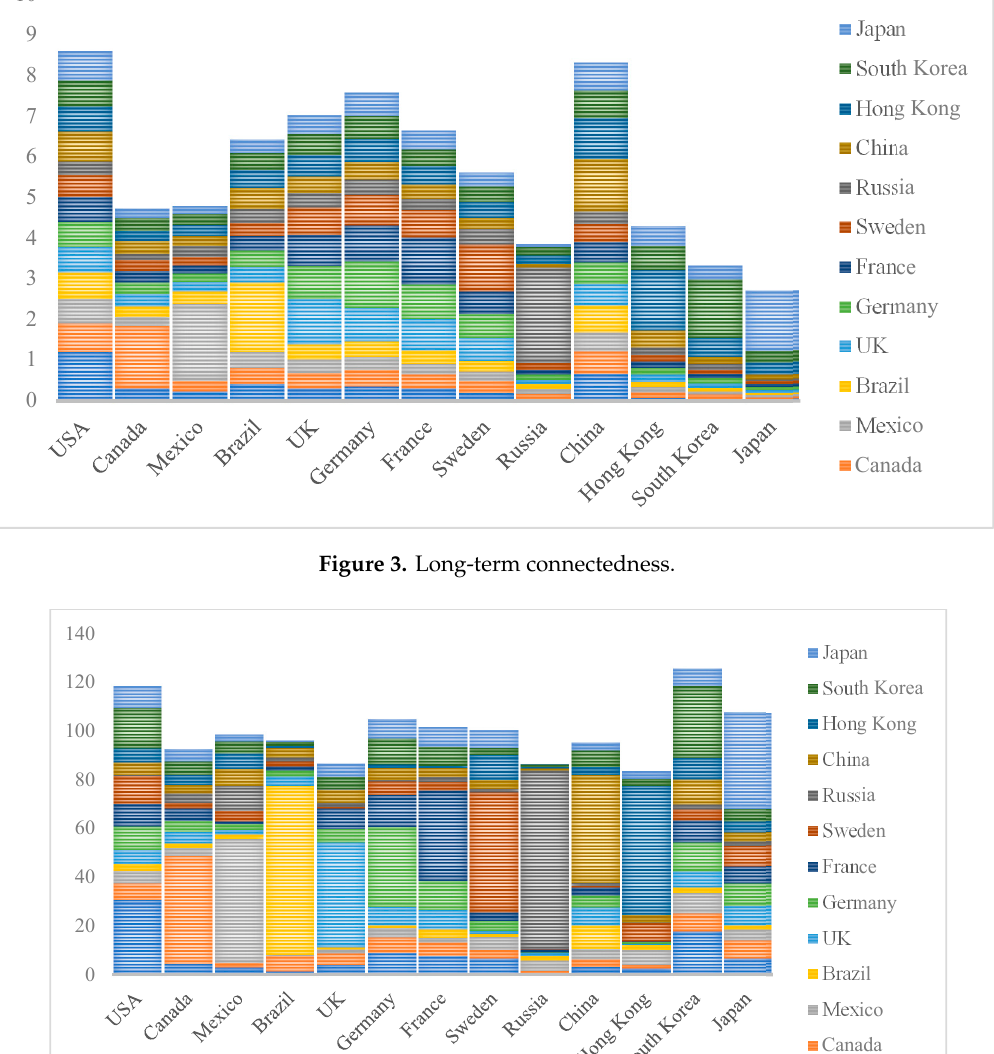
Figure 4. Economic policy uncertainty (EPU) connectedness.